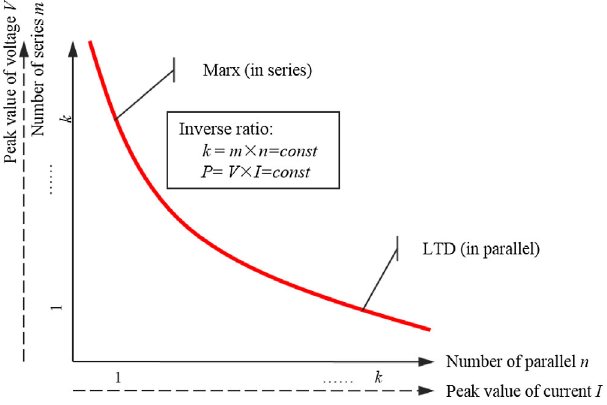
FIG. 1. Inverse relationship of different circuit topologies.